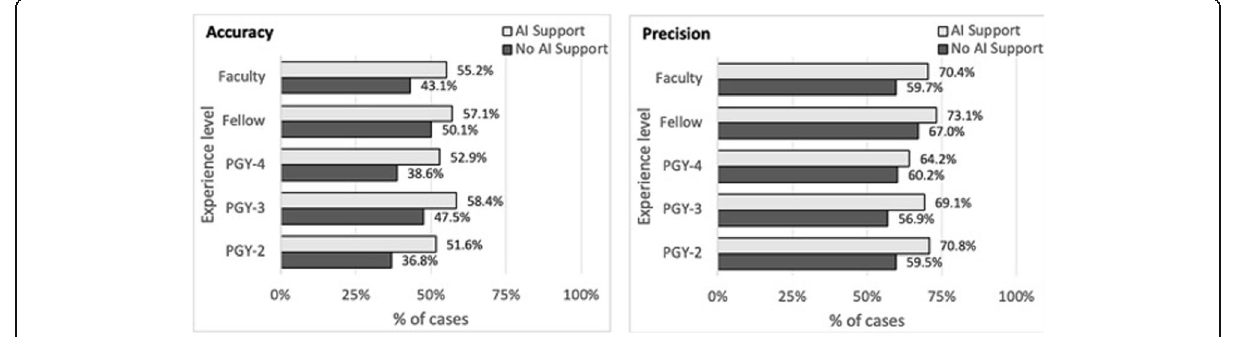
Fig. 4 Accuracy and precision with and without AI support per user experience level